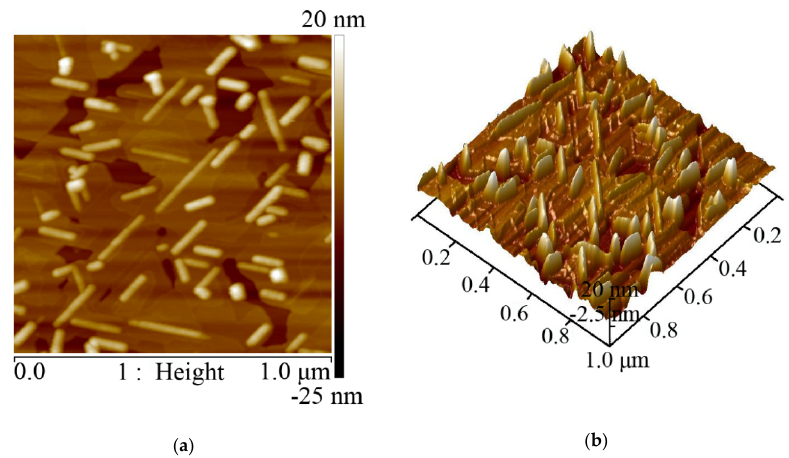
Figure 2. The AFM images of ( a ) top view and ( b ) perspective view of Bi 2 Se 3 on mica substrate. High-resolution TEM measurements were conducted to reveal the Bi 2 Se 3 microstructure. The hexagonal atomic arrangement, as shown in Figure 3a, confirms the c-axis-oriented growth direction of the film. The average distance between the planes is found to be 3.57 Å, as indicated by the red arrows, signifying the lattice constant as a = 4.12 Å. Figure 3c shows the atomic arrangement within the vertical planes. The average spacing between the planes indicated by the white rectangle was found to be 2.20 Å, in good agreement with the calculated value of 2.21 Å between planes along the Bi 2 Se 3 < 5,10,2(cid:3364) > direction. The distance of 2.06 nm between the five atoms along the longer side of the white rectangle coincided nicely with the lattice along Bi 2 Se 3 <500>, in which 5 a = 20.61 Å. These results confirm that the fence-like vertical planes are those that grew along the Bi 2 Se 3 (015) normal. The crystallographic relationship of Bi 2 Se 3 and the mica (001) surface at these different growth orientations is illustrated by using the interface models, as shown in Figure 3b,d,e.